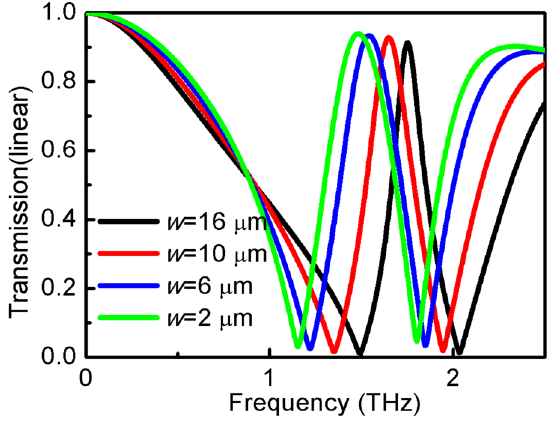
Figure 11. Variation of transmission of the structure at different strips width w